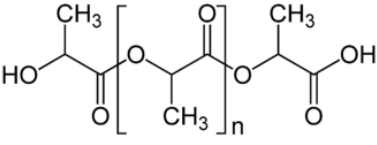
Figure 1. The structural formula of Polylactic acid (PLA).